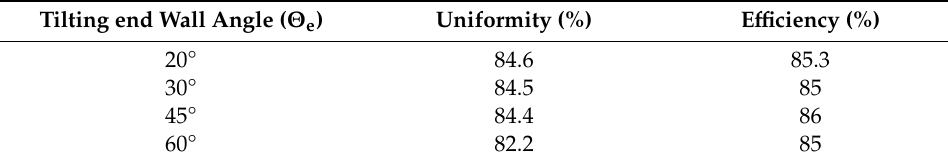
Table 3. Simulated efficiency and uniformity at different 𝚯 𝐞 values .